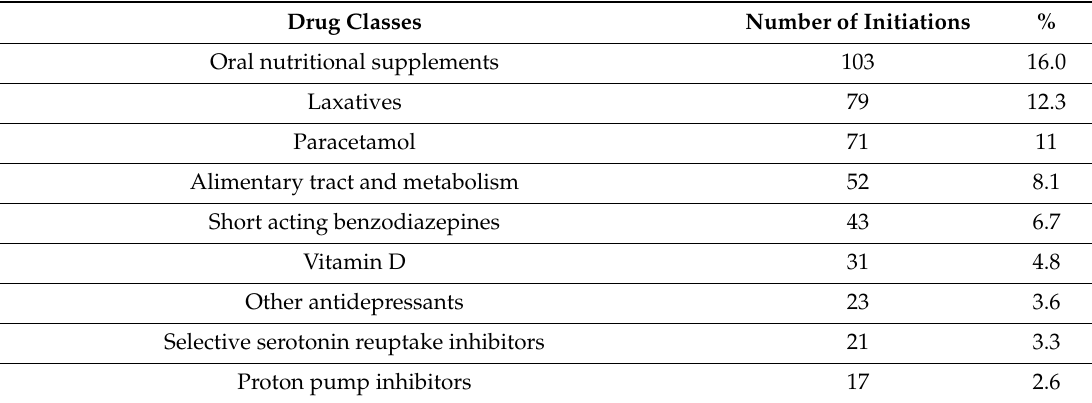
Table 1. Drug initiations during the hospitalization. Drug